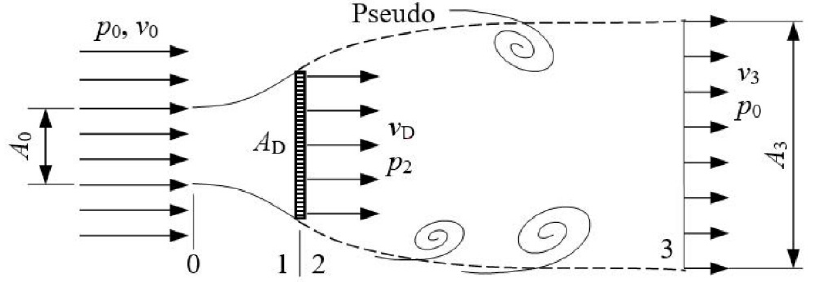
Figure 3. Incorrect disc flow model used for deriving Betz’s law.